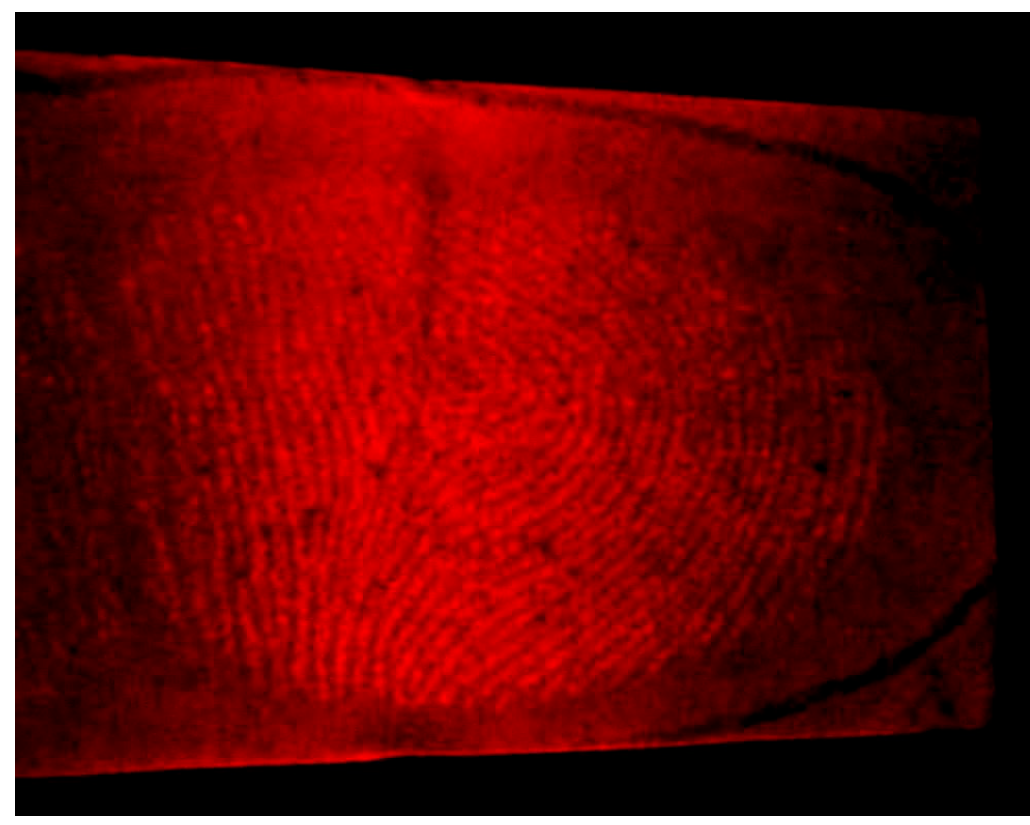
FIGURE 1 . Three-month-old fingerprint on paper developed by SYPRO fi